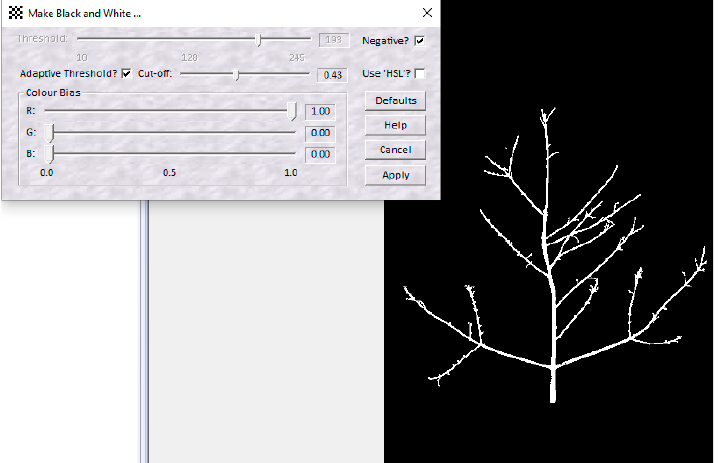
Figure 3. Example of a two-year-old branch from ‘Arbequina’ olive trees after binarization with the thresholding function of the EZ Rhizo II software.